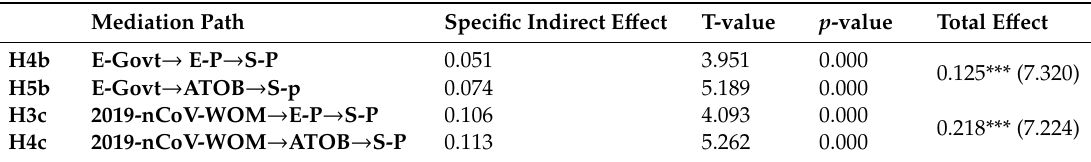
Table 7. Mediation